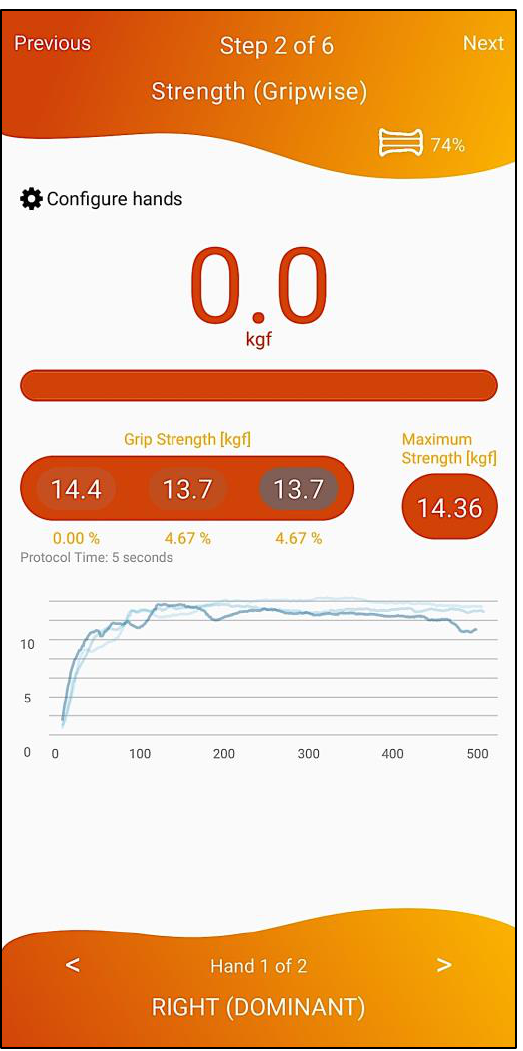
Figure 4 . Handgrip strength evaluation with Gripwise. Figure 4. Handgrip strength evaluation with